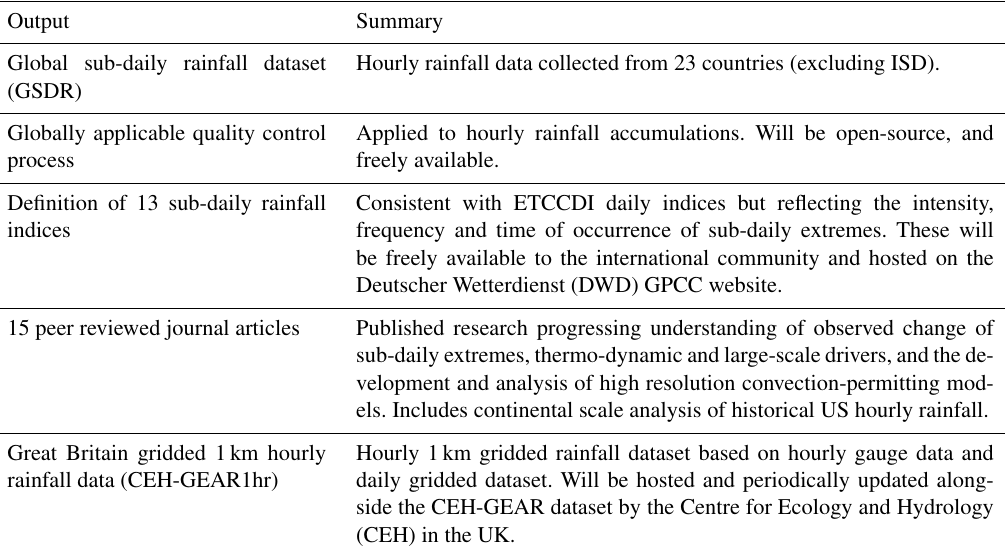
Table 1. Key outputs from the INTENSE project researchers and partners at time of